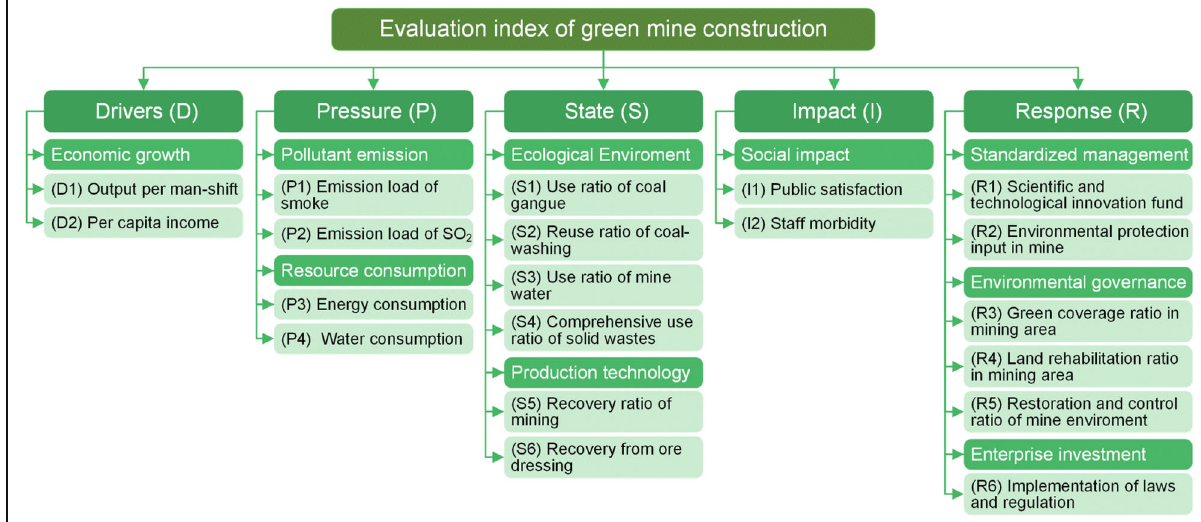
Fig. 2 Hierarchical structure of the green mine evaluation index